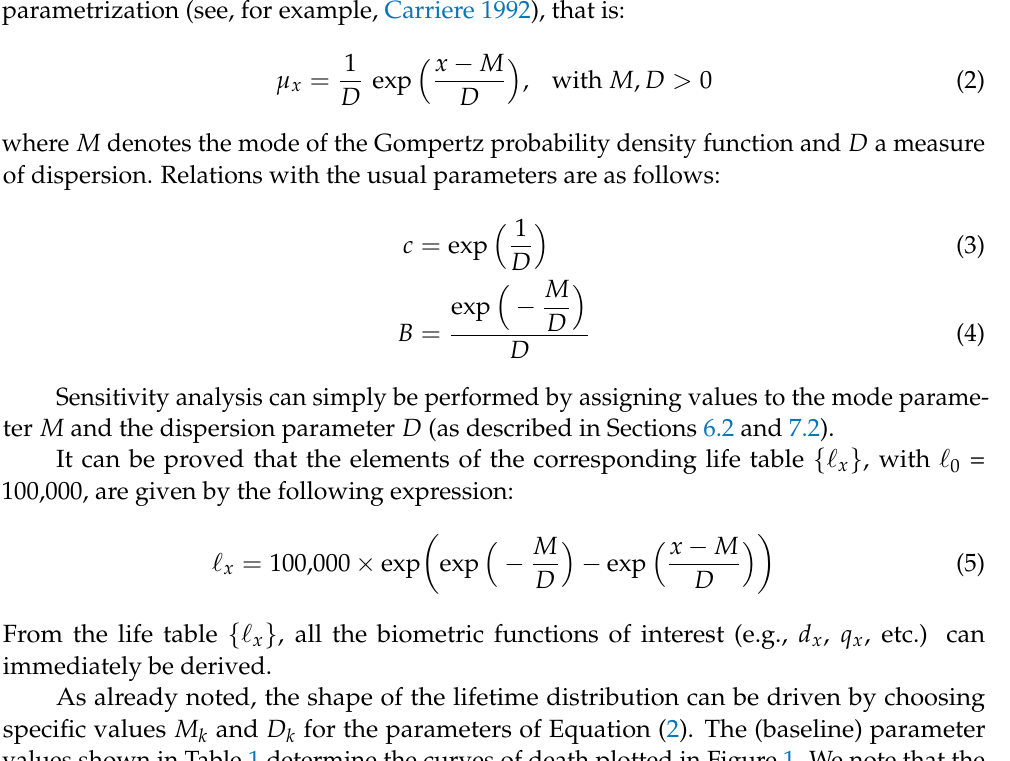
From the life table { (cid:96) x } , all the biometric functions of interest (e.g., d x , q x , etc.) can immediately be derived.